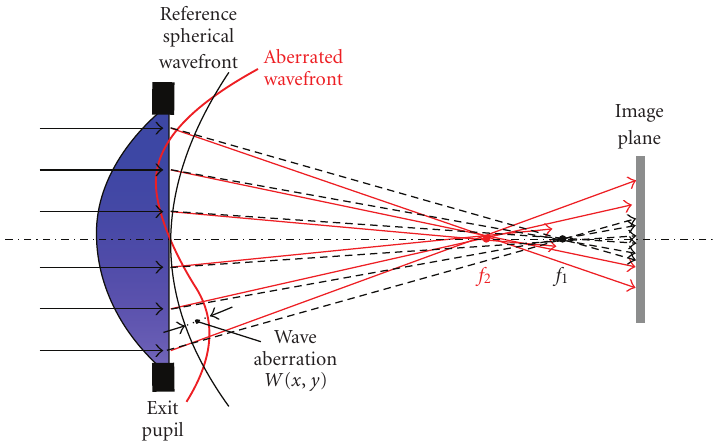
Figure 11: Optical aberration can be described using the so-called wave aberration function. The wave aberration function is defined as the distance (in optical path length) from reference sphere to the wave front in the exit pupil measured along the ray. Optical aberrations negatively a ff ect the image quality, imaging system transfer characteristics, and cut precision of other measurements.